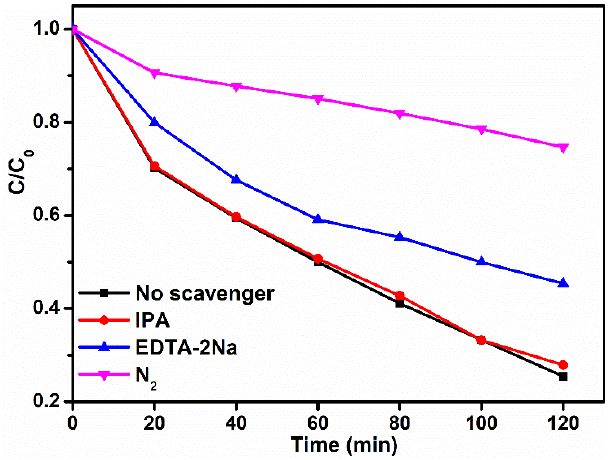
Figure 8. Reactive species trapping experiments over